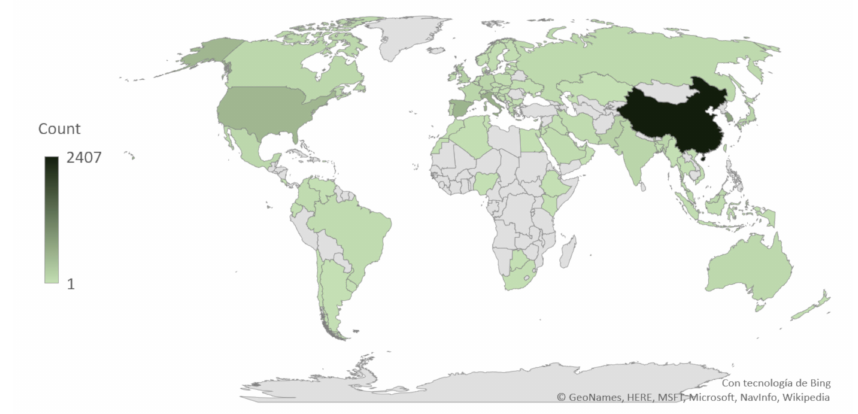
Figure 26. Representation of the 87 countries with contributions from